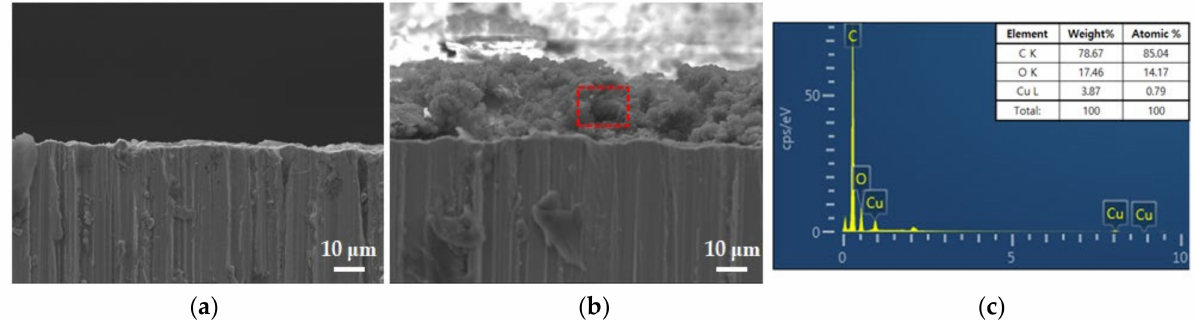
Figure 2. Cross-sectional SEM images of the specimens; ( a ) SEM images of specimen 1 (1000 × ); ( b ) SEM images of the carbonaceous film on specimen 2 (1000 × ); ( c ) EDS result of the carbonaceous film (red dotted-box).